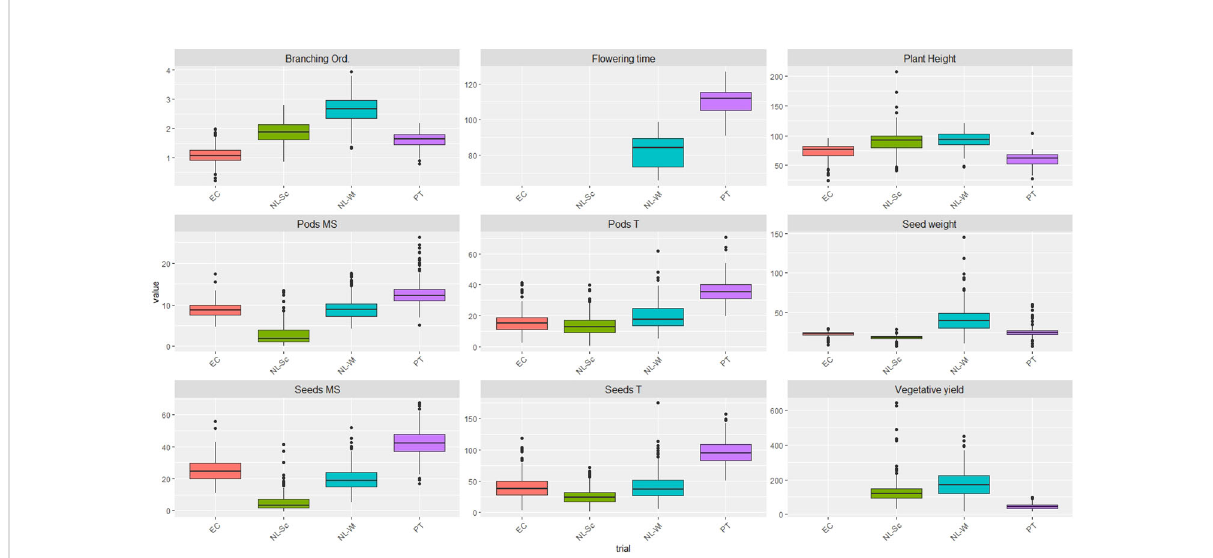
FIGURE 1 Boxplots showing the variation of the plant architecture and yield related traits (BLUES data) under study in a collection of 223 L. mutabilis accessions. The upper and lower end of the boxes indicate respectively the 75th and 25th percentiles, while the line in the middle represents the 50th percentile (median). The whiskers represent the highest and lowest values, while circles represent outliers outside the 5th-95th percentile